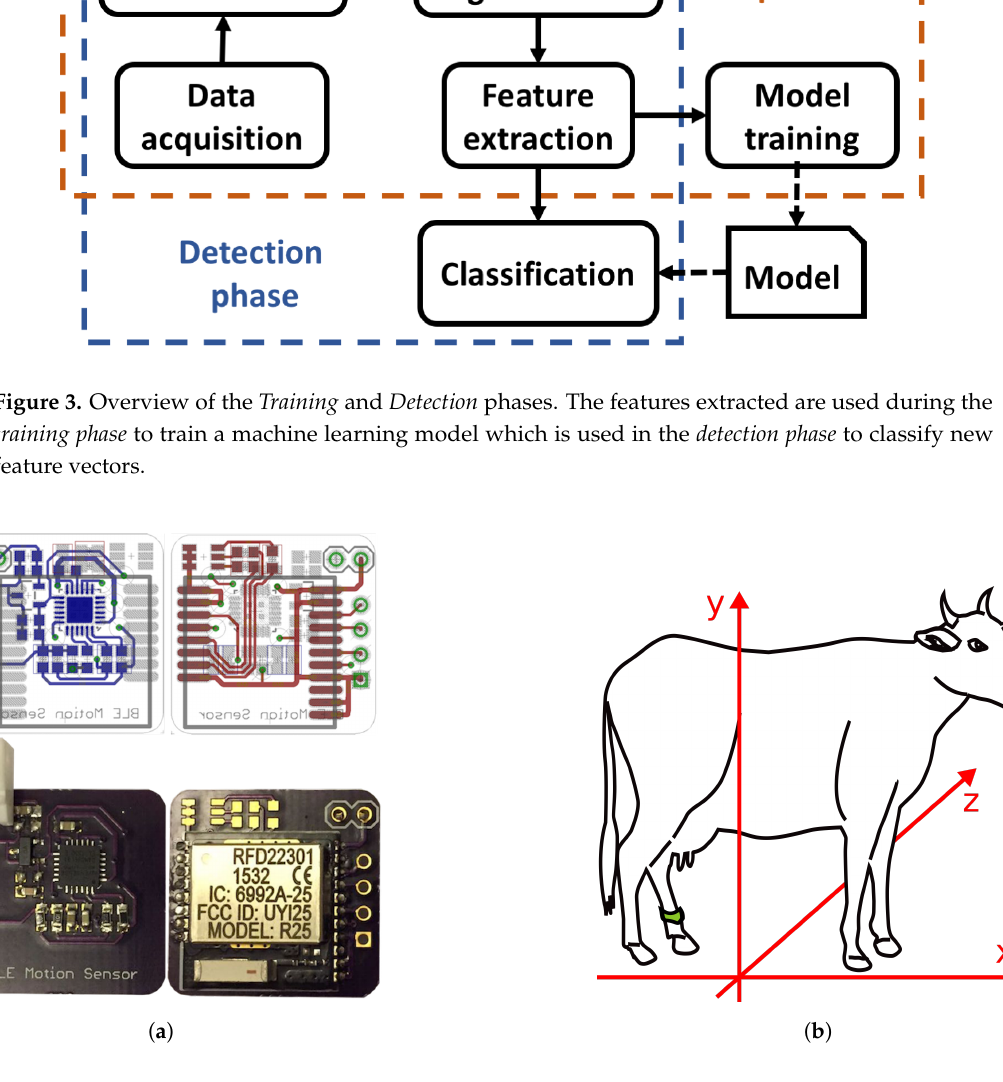
Figure 4. Motion sensor and Eagle schematics for front and back sides of the Printed Circuit Board (PCB) ( a ) and the orientation of our device ( b ). Our device is oriented such that the y -axis represents vertical accelerations, the x -axis is parallel to the cow (i.e., in its walking direction) and the z -axis is lateral (i.e., left and right) to a